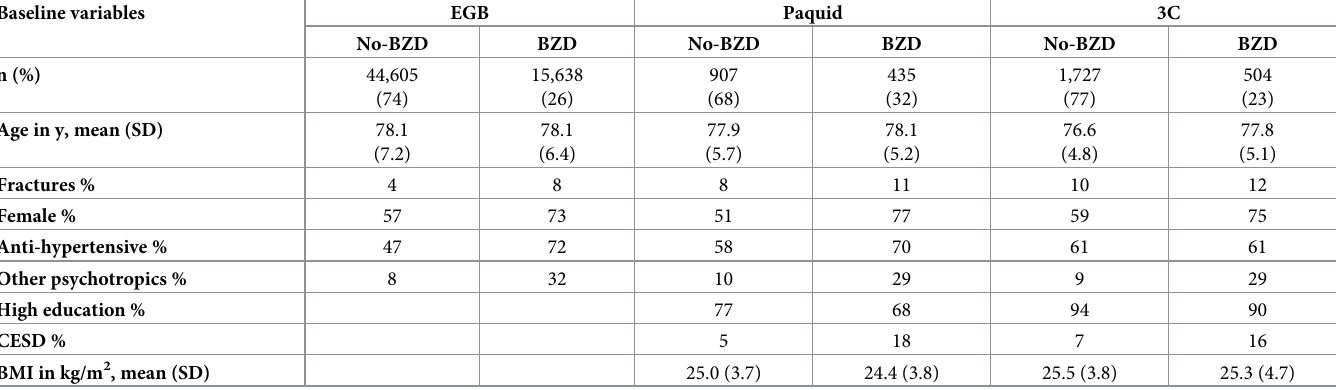
Table 1. Description of study population in main (EGB, n = 60,243, 2006–2009) and validation samples (Paquid, n = 1,342, 1993–1997; 3C, n = 2,231, 2003–2007) in France.